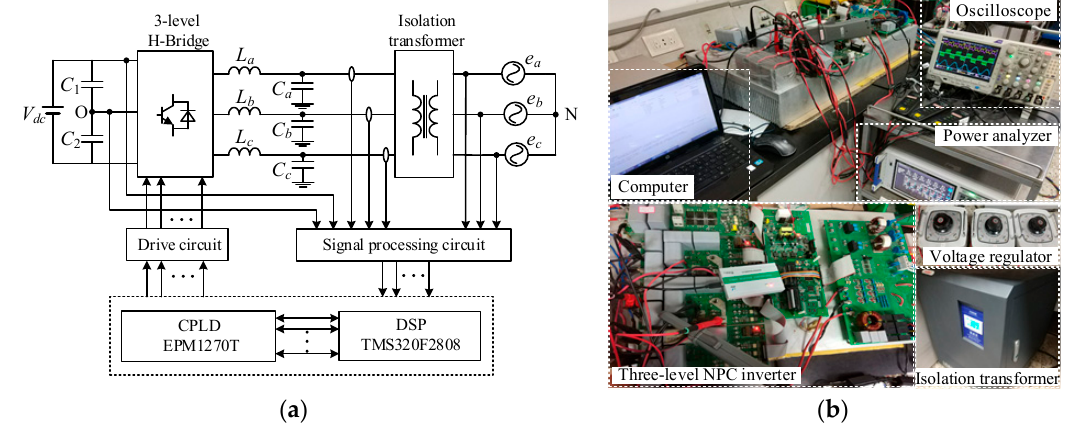
Figure 10. The schematic diagram and experimental photograph of the system: ( a ) Schematic diagram of the system; ( b ) Experimental photograph of the system. Table 3. Specifications of the experimental prototype.